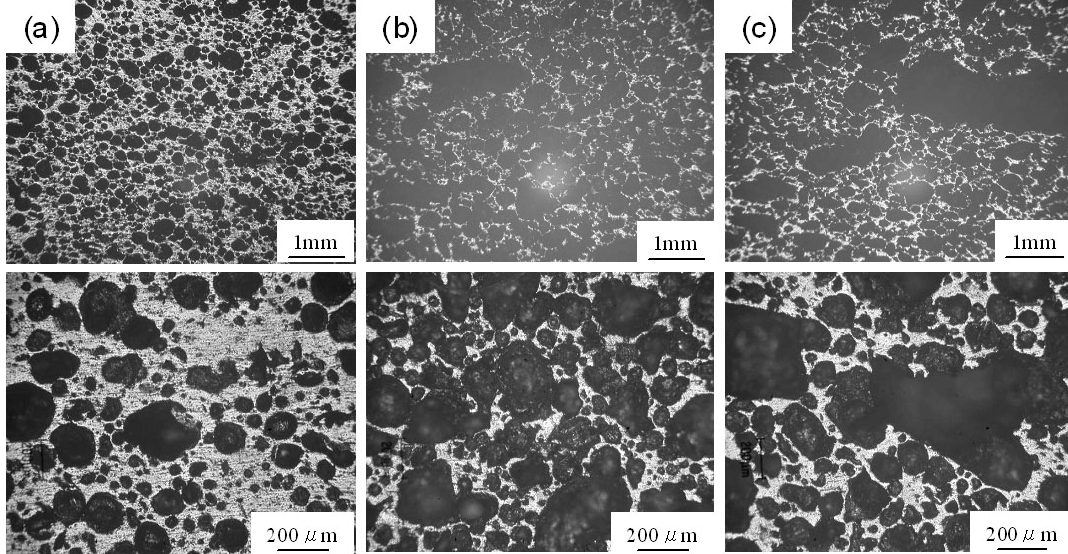
Figure 7. Microstructures of foams produced using 2.0 mass% dolomite and 1.0 mass% MgCO , lower pictures are magnified images of upper row: ( a ) at 903 K, ρ : 0.87 g/cm 3 ; 3 ( b ) at 933 K, ρ : 0.58 g/cm 3 , and ( c ) at 973 K, ρ : 0.66 g/cm 3 .